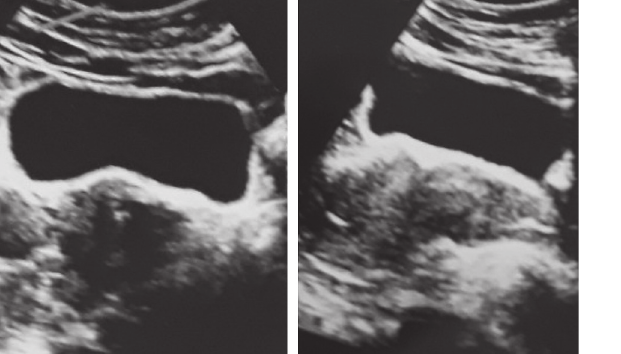
Figure 2: Both ovaries are enlarged; R/ovary:14ml; L/ovary:17 ml; multiple small follicles are seen at the periphery of the ovary; prominent stroma